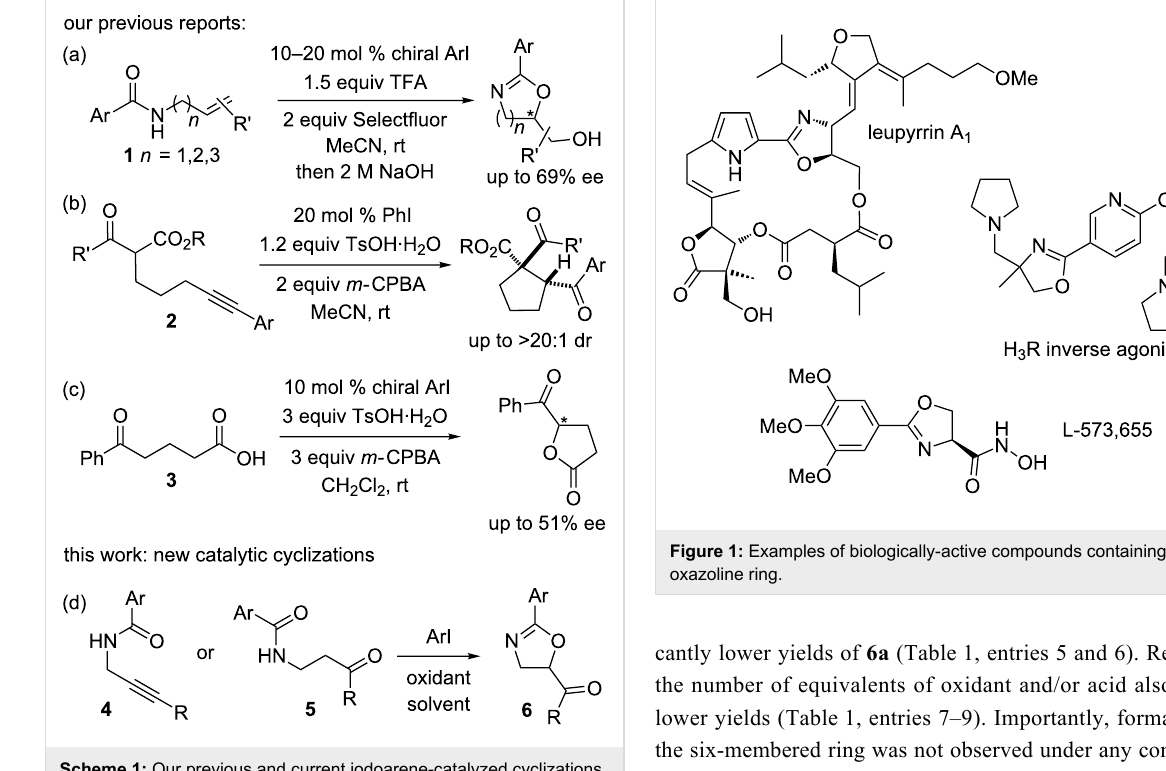
Scheme 1: Our previous and current iodoarene-catalyzed cyclizations.